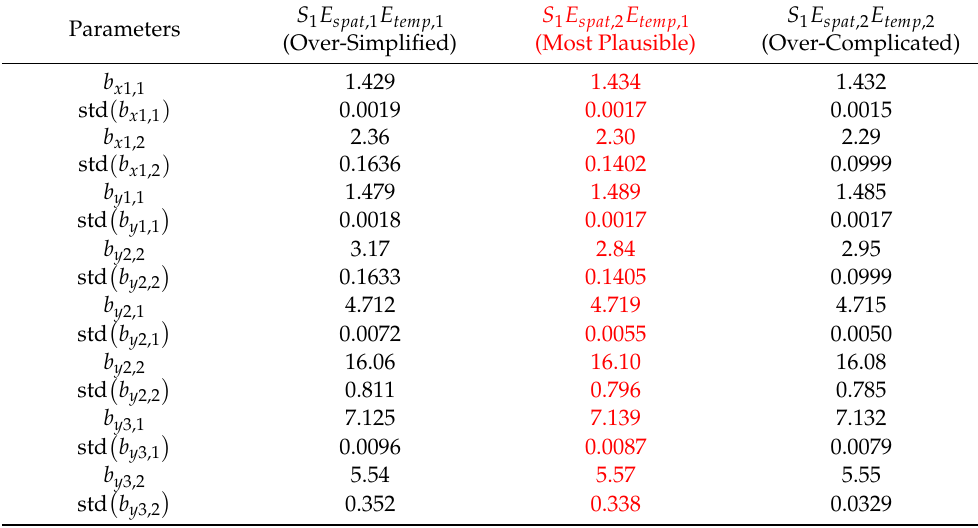
Table 7. Parameter identification results (modal frequency